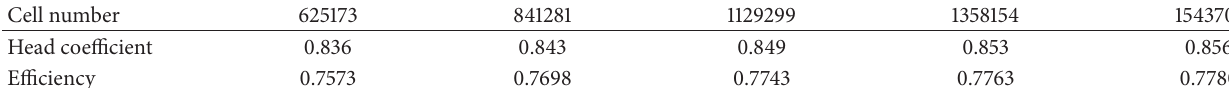
Table 4: Grid independence analysis.